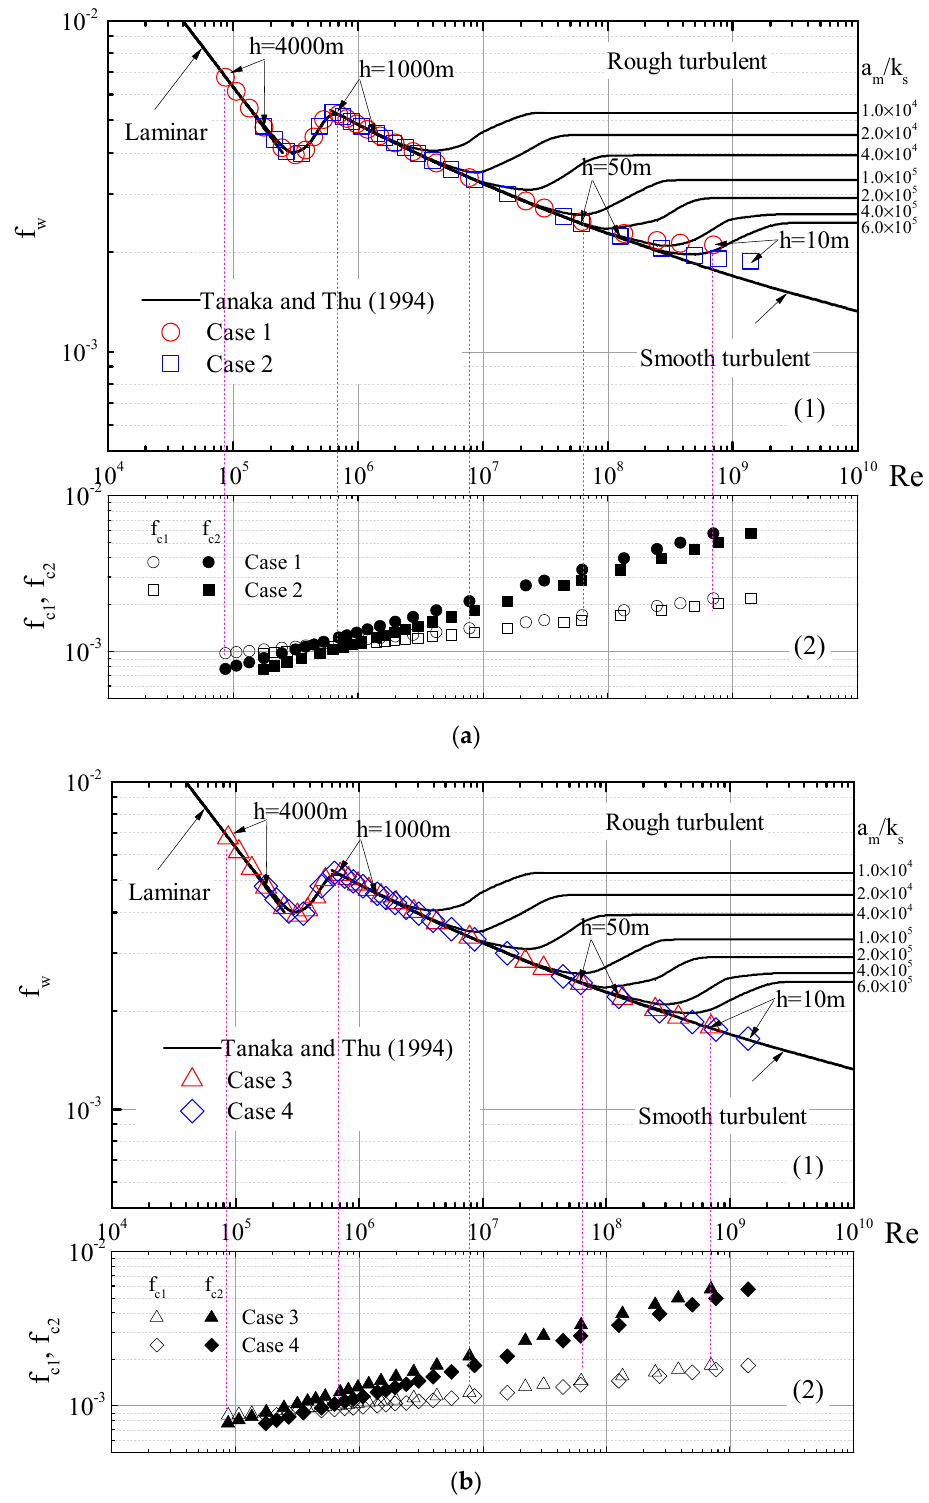
Figure 7. Transitional behavior of the friction coe ffi cient. ( a ) Case 1, Case 2 ( d = 0.3 mm), ( b ) Case 3, Case 4 ( d = 0.1